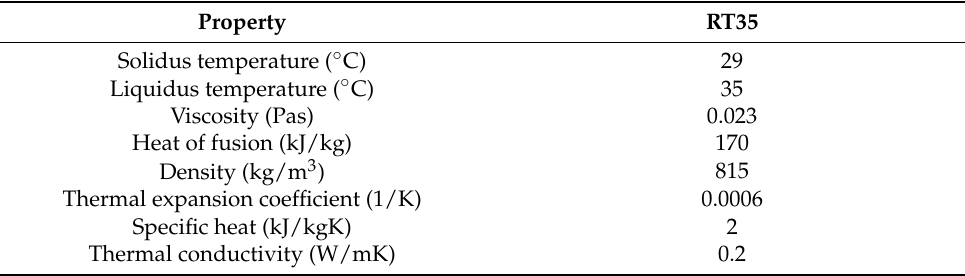
Table 1. Thermal properties of RT35